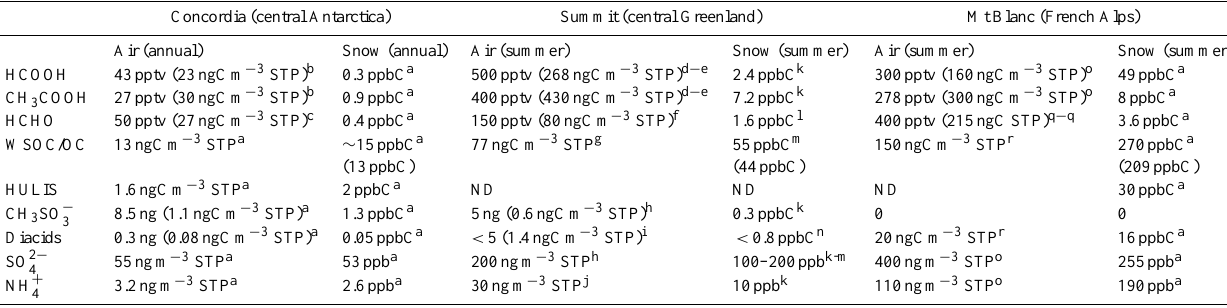
Table 3. Air and snow concentrations of various species observed at Concordia, Summit, and Mt Blanc. Species include atmospheric gases (HCOOH, CH 3 COOH, and HCHO) and aerosol such as water-soluble organic carbon (WSOC), humic-like substances (HULIS), methane- sulfonate (CH 3 SO − ), dicarboxylates, sulfate, ammonium, and sodium. For OC concentrations of snow, we also report (values in parentheses) 3 the calculated WSOC ∗ fraction (see Sect.